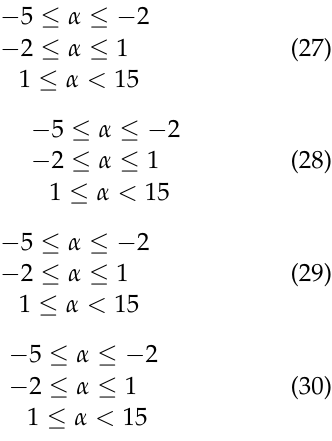
Figure 9. FX63 airfoil performance for Re = 100,000–1,000,000. The polynomial fitting method in MATLAB was used to interpolate the lift and drag coefficient curves, when the Reynolds number increased from 1000 to 1,000,000. The airfoil lift and drag coefficient curves at Re = 8000 and 200,000 are presented in Figures 10 and 11, respectively. The polynomial curves were in good agreement with the CFD data. The polynomial equations are reported below the